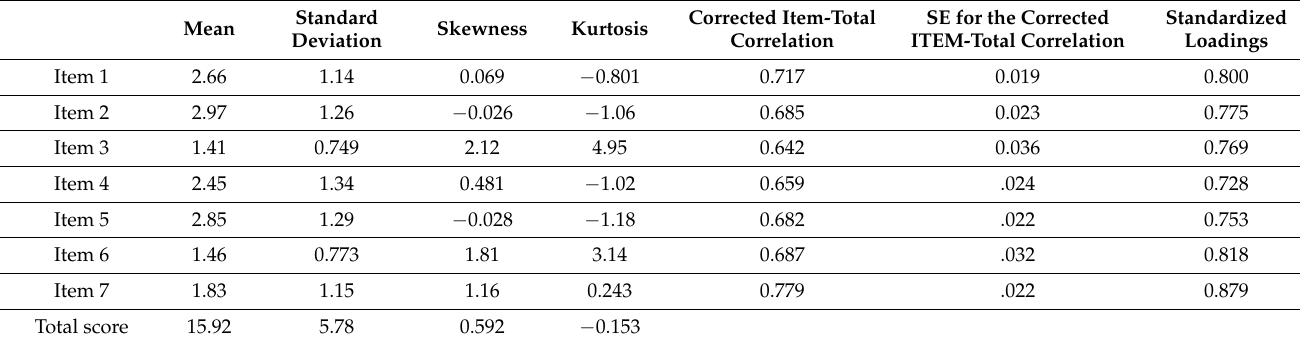
Table 1. Descriptive statistics for the items on the Fear of Covid-19 Scale and for the total score on the scale, corrected item- total polyserial correlations with standard errors (SE), and standardized factor loadings of the confirmatory factor analysis. Standard Corrected Item-Total SE for the Corrected Standardized Mean Skewness Kurtosis Deviation Correlation ITEM-Total Correlation